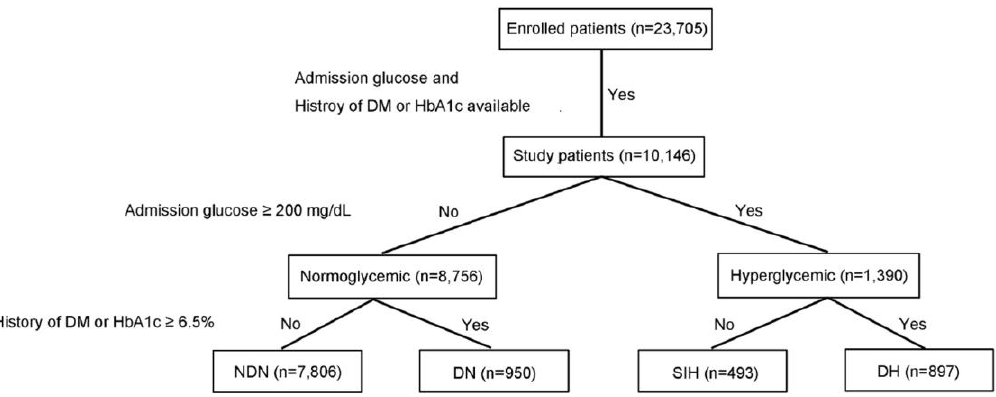
Figure 1. Flow chart of allocating patients into groups of non-diabetic normoglycemia (NDN), diabetic normoglycemia (DN), stress-induced hyperglycemia (SIH), and diabetic hyperglycemia (DH).